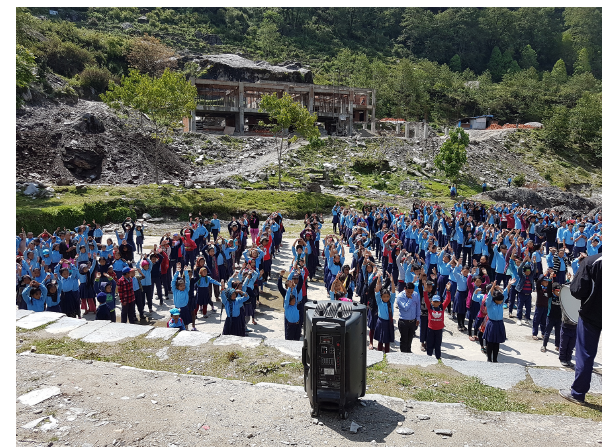
Figure 2. Students gathered for the morning assembly at the Shree Himalaya Secondary School, Barpak, Gorkha district in May 2018. The school building was damaged during the 2015 earthquake, and students were in temporary shelters. The construction of the new building is visible at the top of the picture. (Photo: Shiba Subedi, with the permission of the